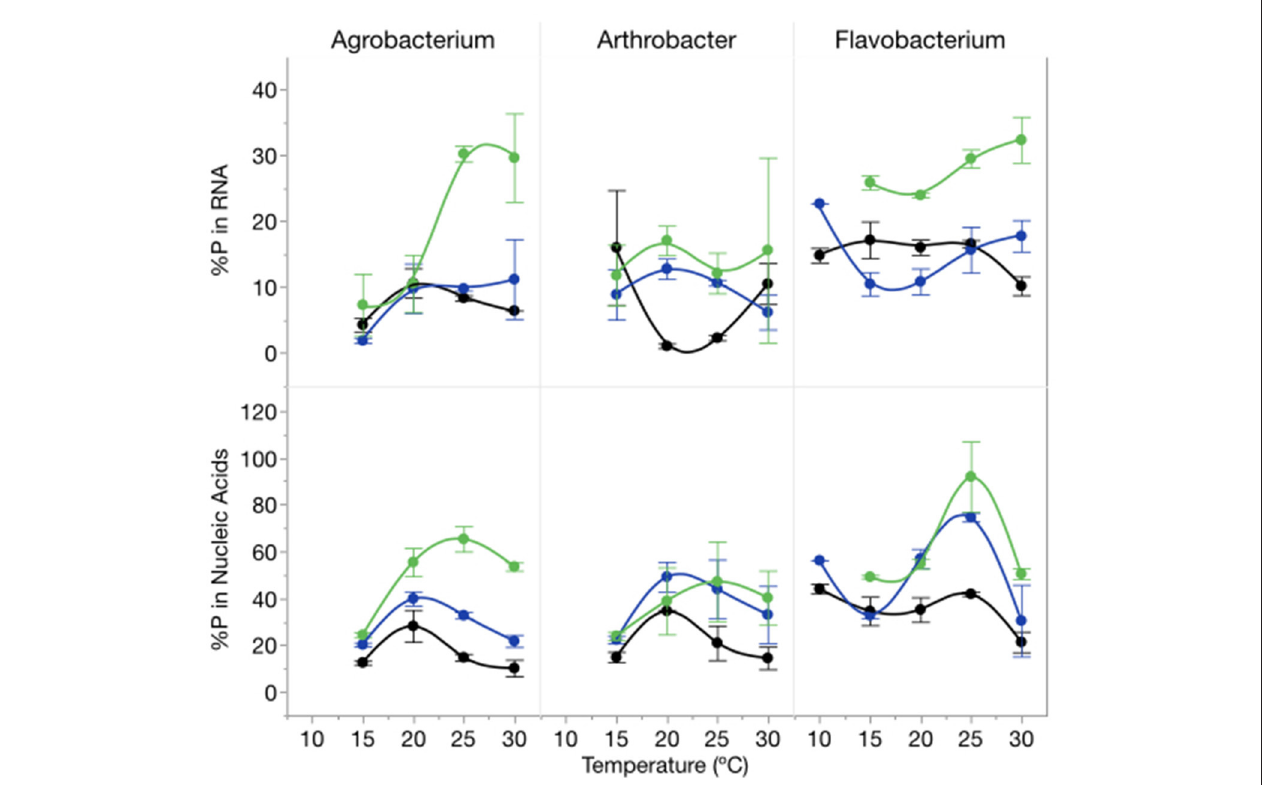
FIGURE 6 | Changes in %P in RNA (top panel) and %P in nucleic acids (bottom panel) for each strain across temperatures and C:P R with different symbols for each level of supply C:P (black-50:1; blue: 250:1; green: 1000:1). Error bars represent one standard error of the mean.